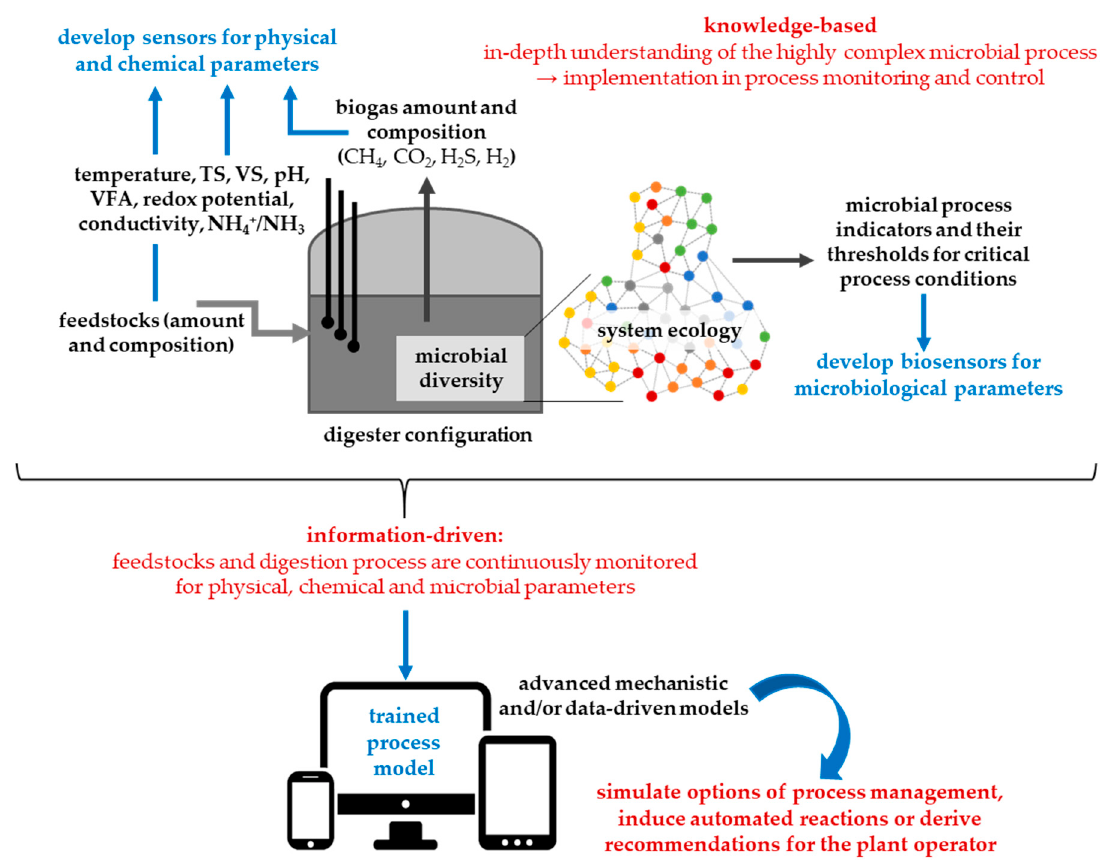
Figure 2. Knowledge-based, information-driven and largely automated biogas production (red font—research objectives, blue font—research demand, black font—research results for implementation).